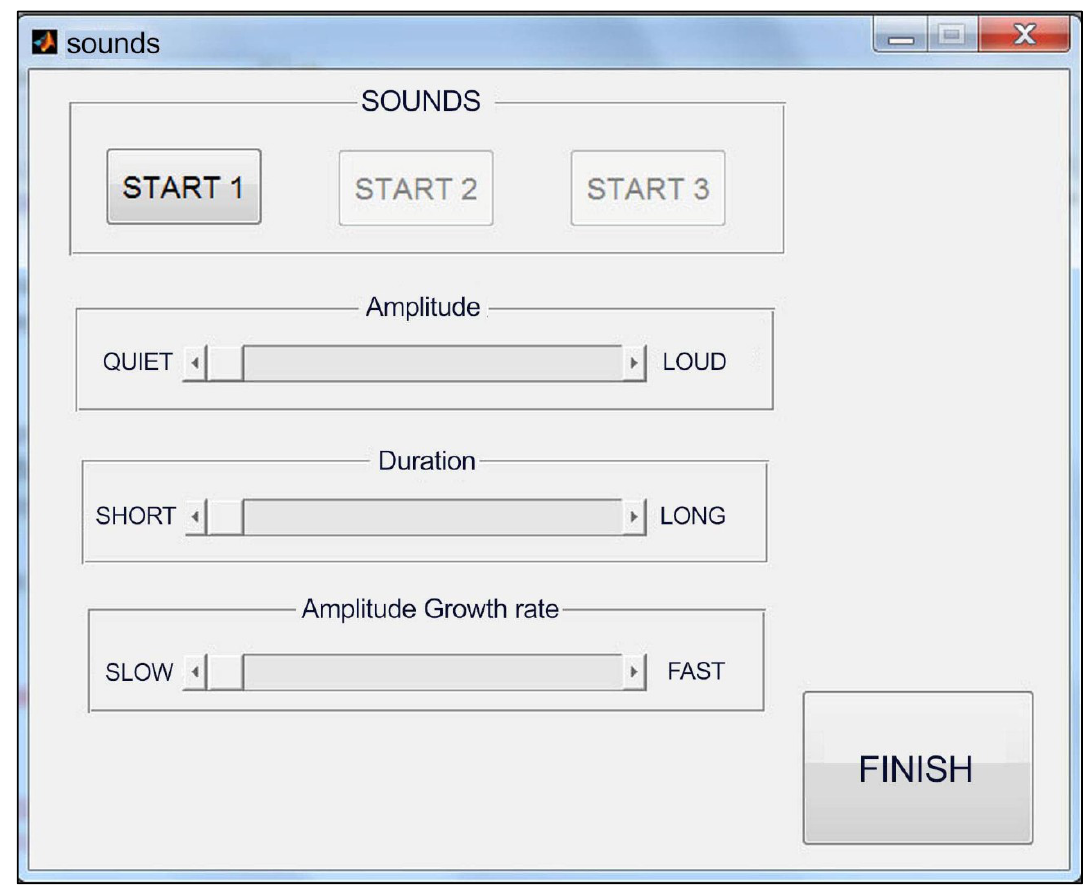
Figure 4. Interface programmed in Matlab.